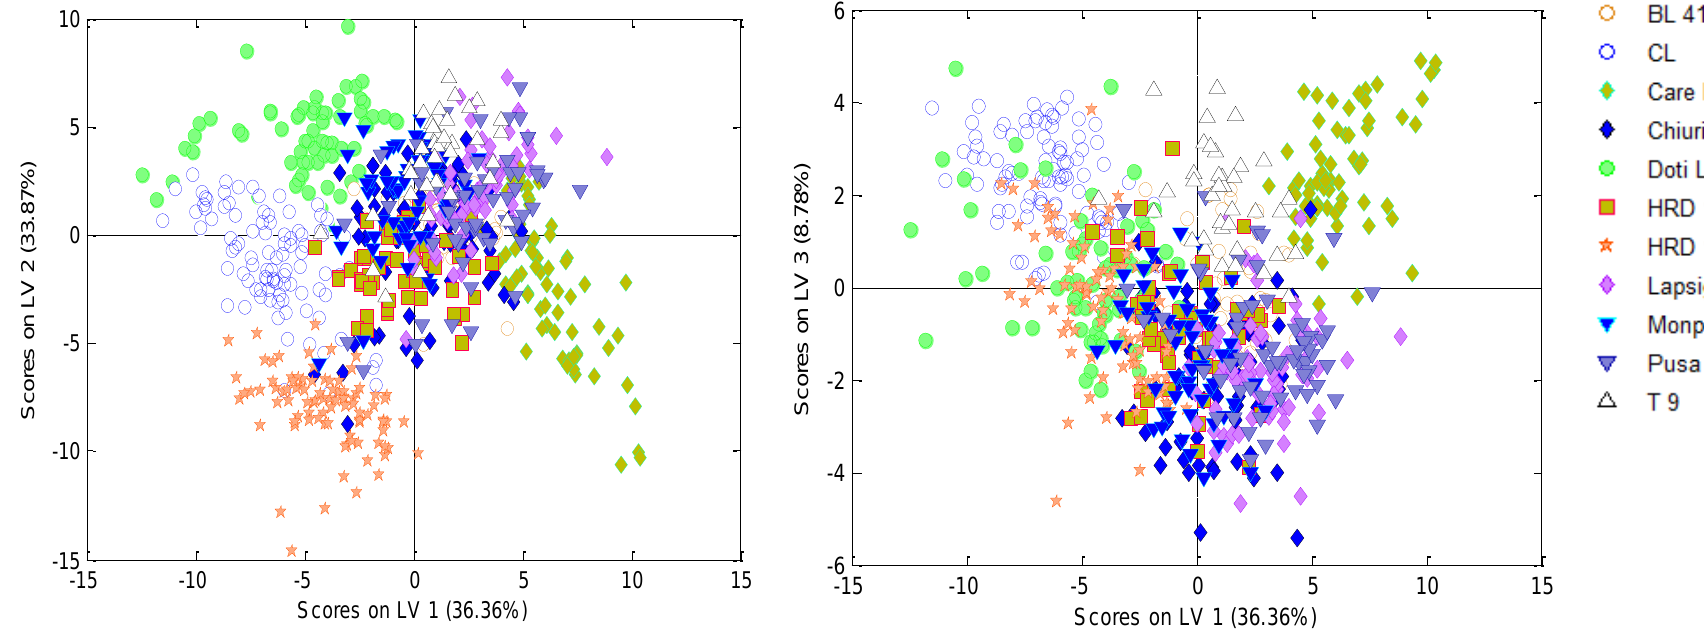
Figure 7. Score plot showing the clustering of eleven tomato